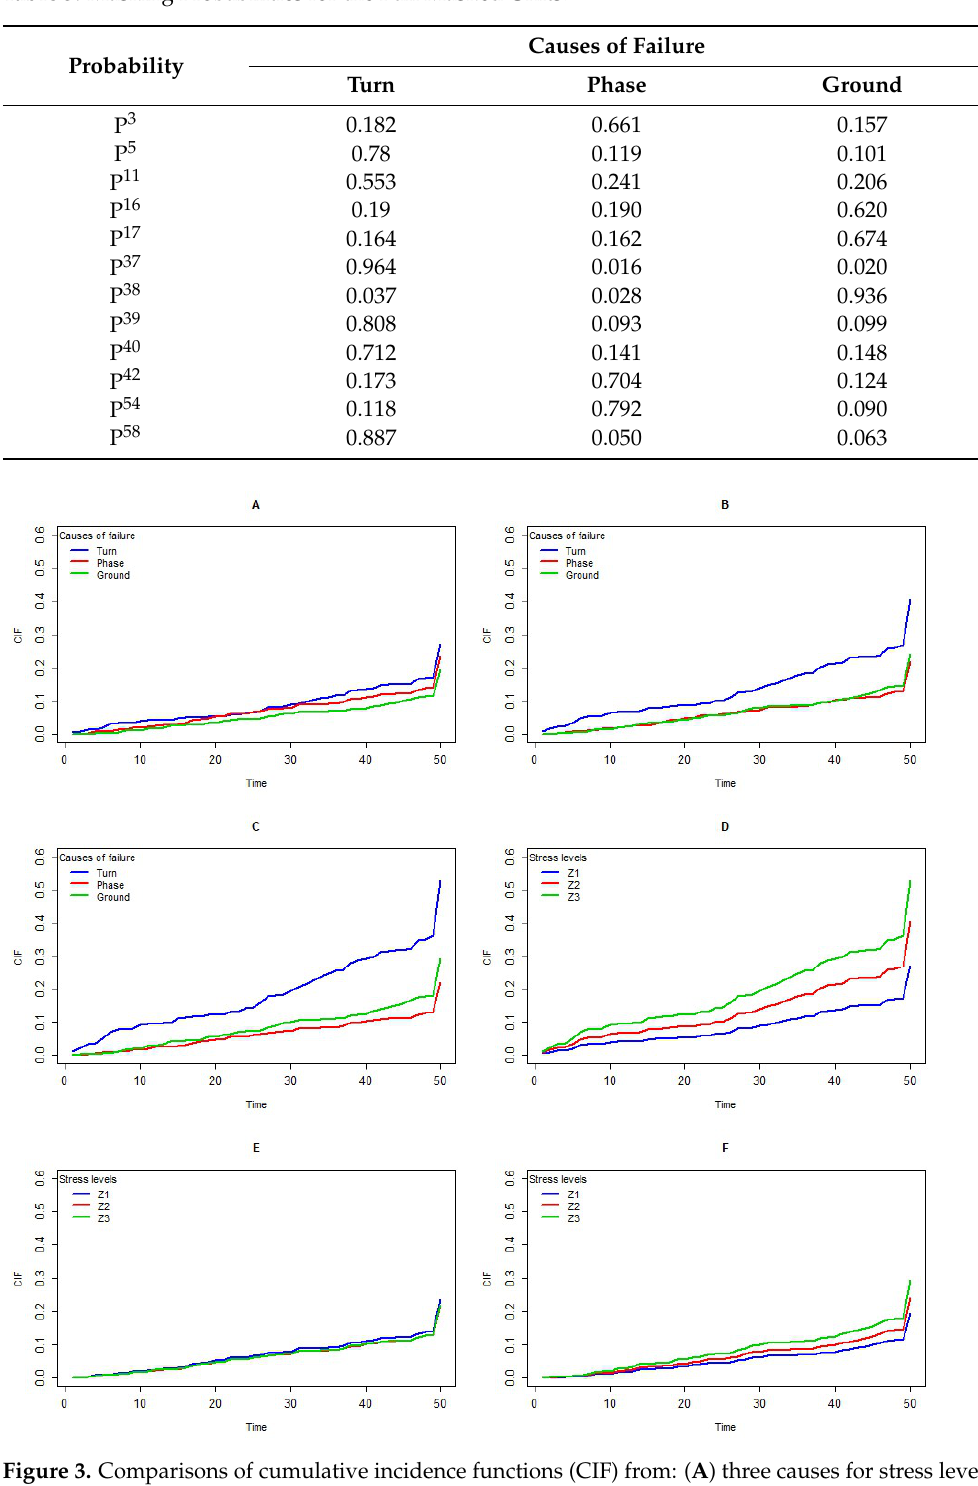
Table 3. Masking Probabilities for the Full Masked Units.